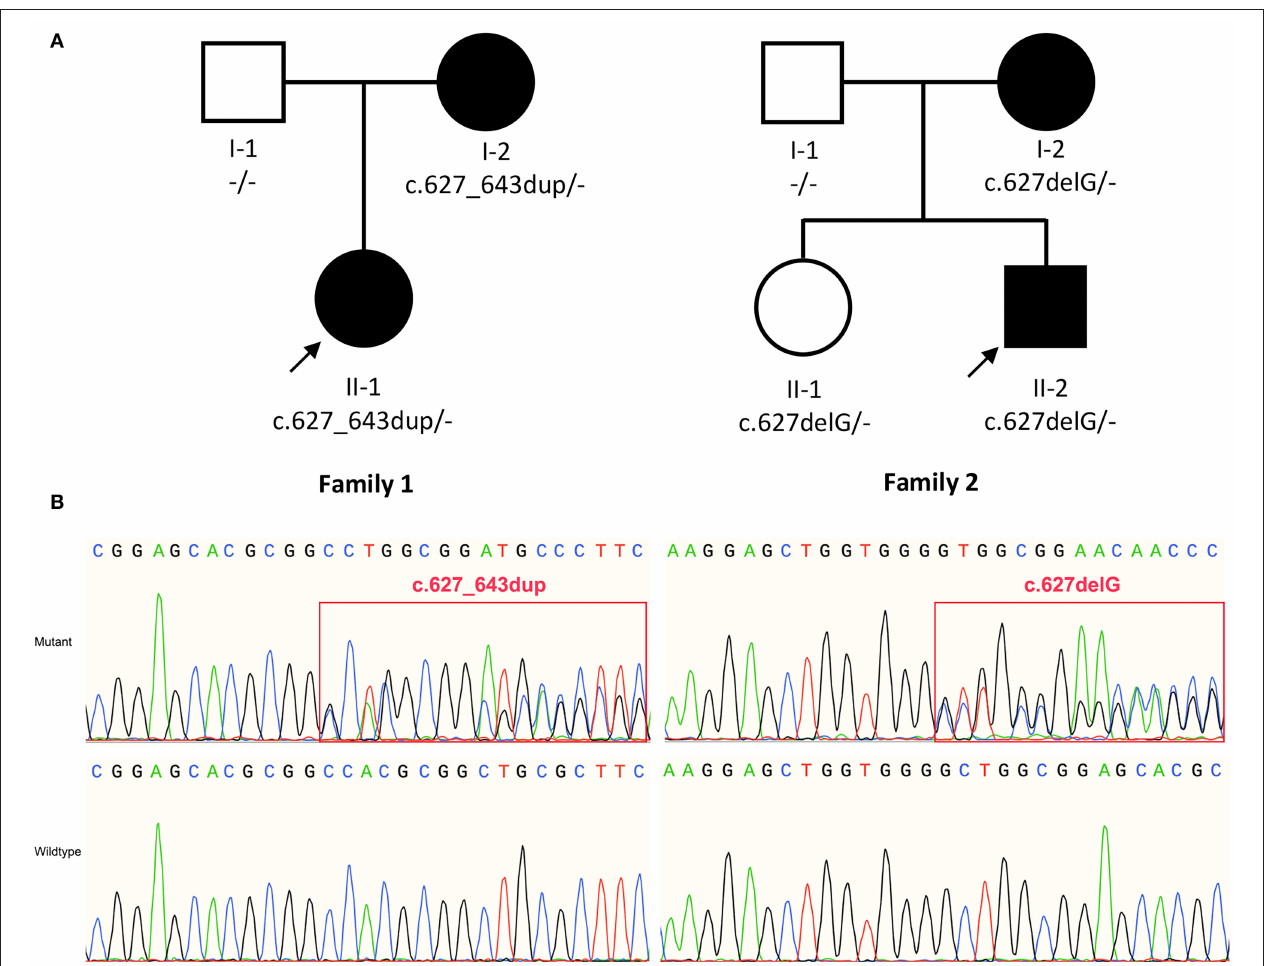
FIGURE 1 | (A) Pedigree of family 1 and family 2. (B) Sanger sequencing show variant c.627_643dup (p. A215Gfs * 53) and c.627delG (p.L210Wfs * 52) identified in TMEM151A gene. The bold arrow indicates probands.